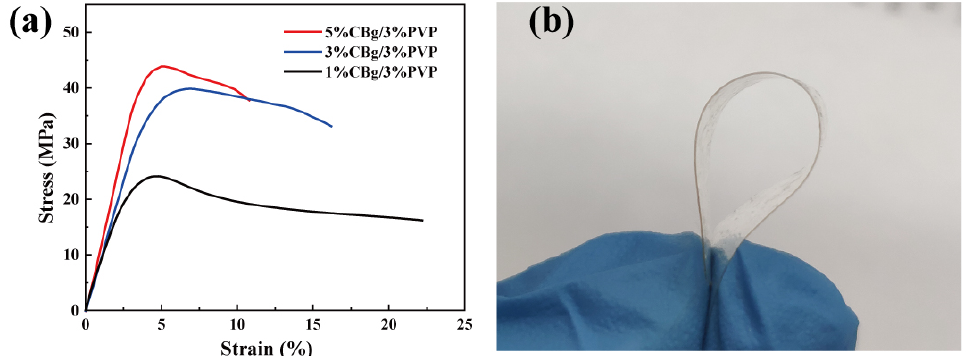
Table 1. Mechanical properties and WVP of CBg/PVP films with different mass concentrations.